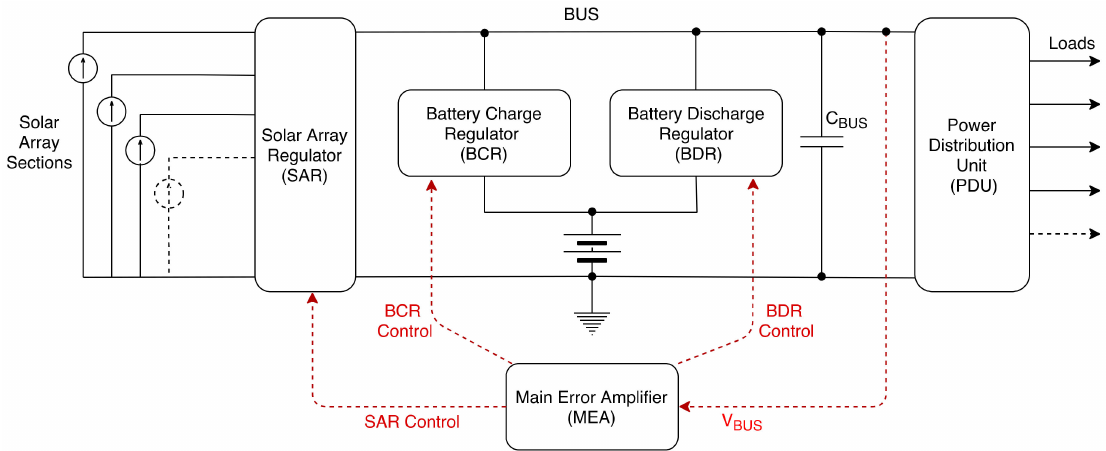
Figure 1. Regulated power bus architecture.